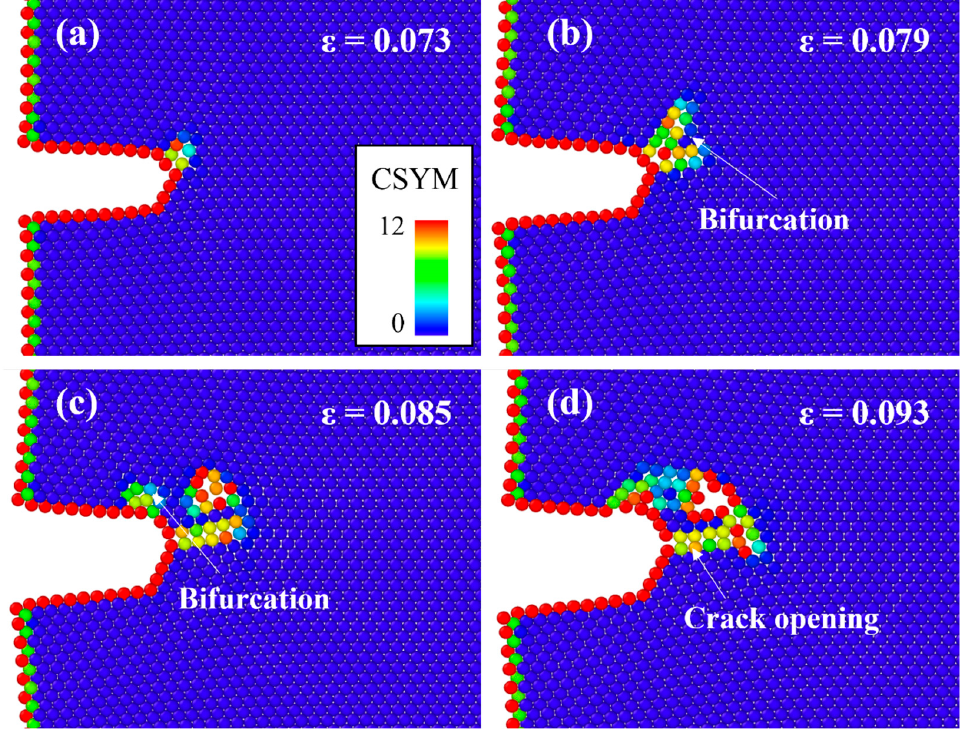
Figure 4. Atomic configurations of a cracked Al single crystal at the strain of ( a ) ε = 0.073, ( b ) ε = 0.079, ( c ) ε = 0.085, and ( d ) ε = 0.093. The different colors represent the CSYM parameters.